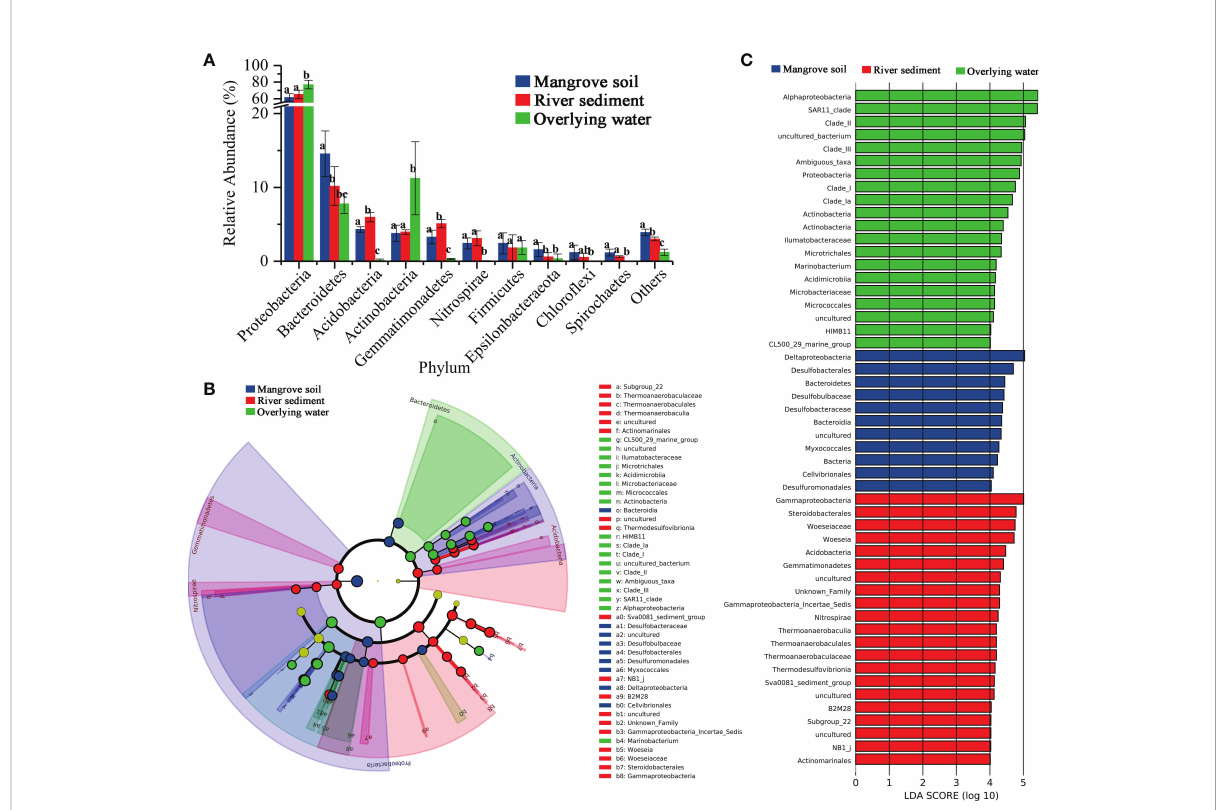
FIGURE 3 Relative abundances of bacterial phyla in distinct microhabitats (A) . The cladogram of bacterial communities obtained using LEfSe analysis (B) . The lineages with linear discriminant analysis (LDA) score of the abundance of taxa (C) . Letters (a, b, and c) indicate signi fi cant difference of p < 0.01 between the sources (one-way ANOVA test). Only the taxa that LDA value above 4.0 are shown.